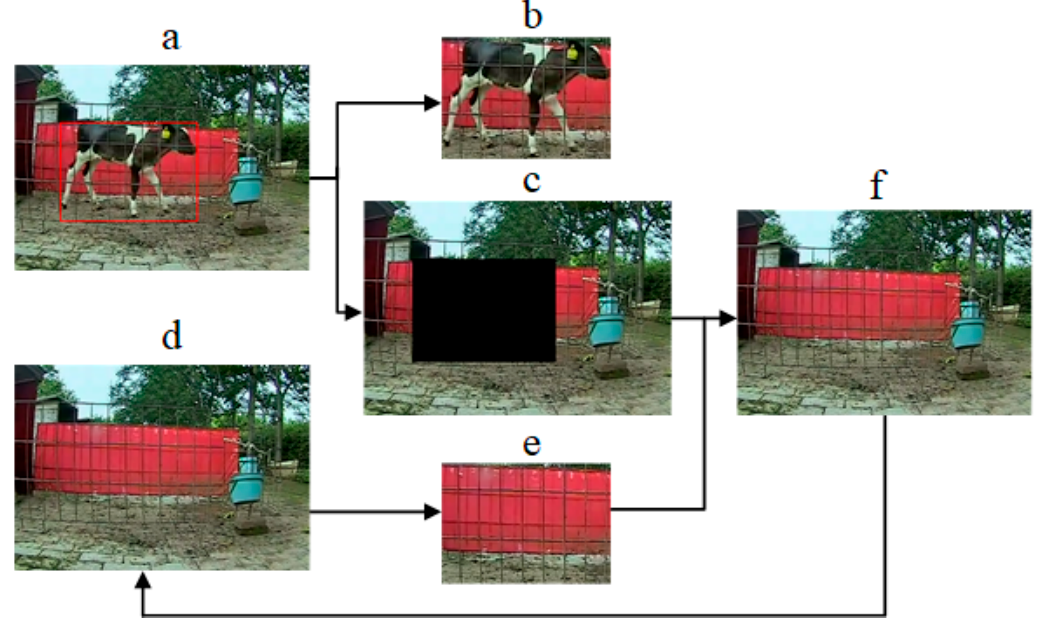
Figure 3. Model of background updating: a . target test results and the red box represents target area; b . target area; c . background area after removing target area; d . previous synthetic background frame; e . background area corresponding to target area; and f . synthetic background frame.